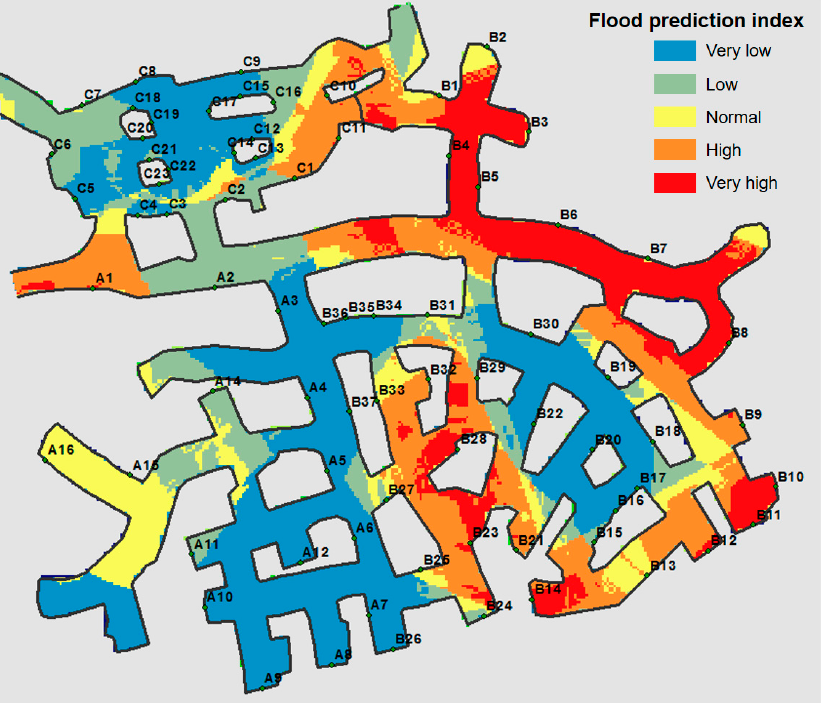
Figure 6. Flood prediction map of underground limestone mining area with five categories using the FR model based statistical analysis of the five data elements (modified from Park et al. [28]).